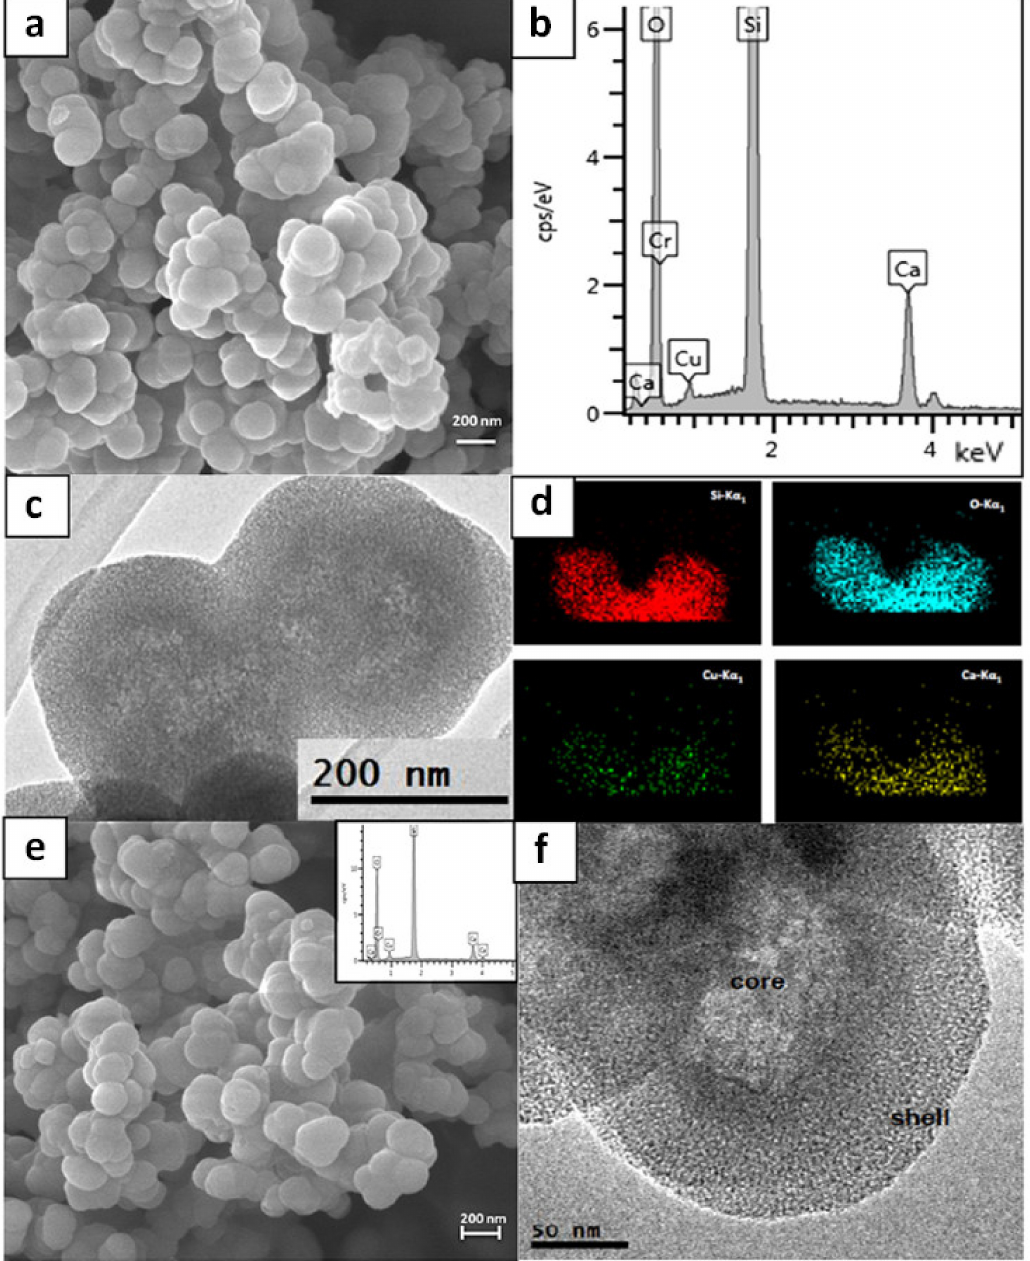
Figure 2. Scanning electron microscopic image of Cu_MBG 2% ( a ), EDS spectrum ( b ), TEM image ( c ) and EDS